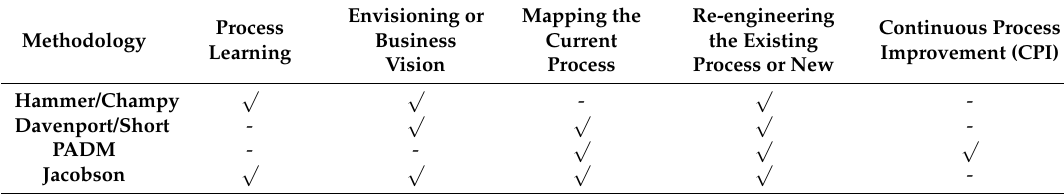
Table 2. Comparison of